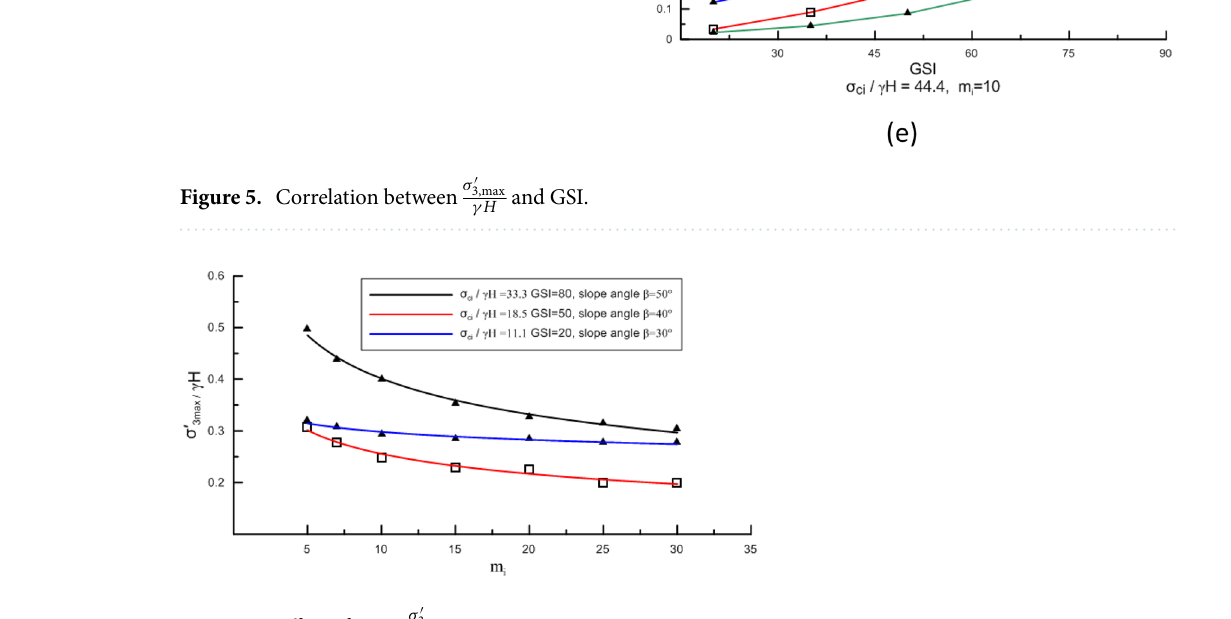
Figure 6. Effect of m i on